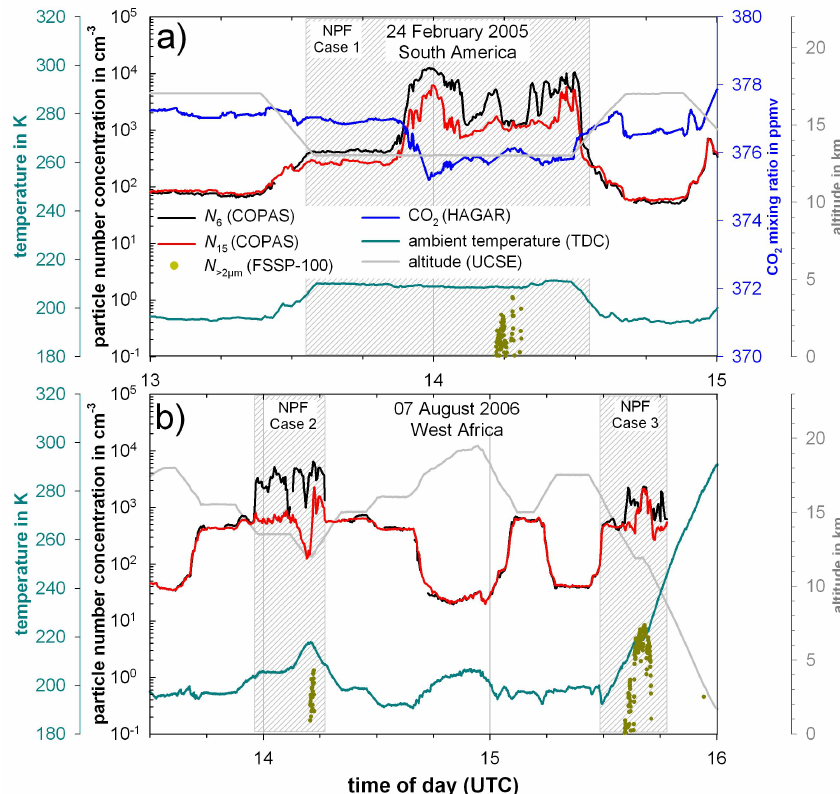
Fig. 4. Cases of increased concentration of nucleation mode particles indicating New Particle Formation (NPF – shaded areas): (a) Case 1 during the flight from Arac¸atuba to Recife, Brazil, on 24 February 2005 (TROCCINOX). (b) Cases 2 and 3 during a local flight over West Africa on 7 August 2006 (SCOUT-AMMA). The difference in particle concentrations, N 6 – N 15 , is indicative of recent NPF. Lines: grey – flight altitude; dark cyan – ambient temperatures; blue – in situ measured CO 2 mixing ratio (not available for the SCOUT-AMMA flight on 7 August 2006). Green dots: flight time period inside a cirrus cloud as indicated by N > 2 µ m measured by FSSP-100. Gaps in the N 6 time series of (b) are caused by discarding data in case the measurements were affected by electronic